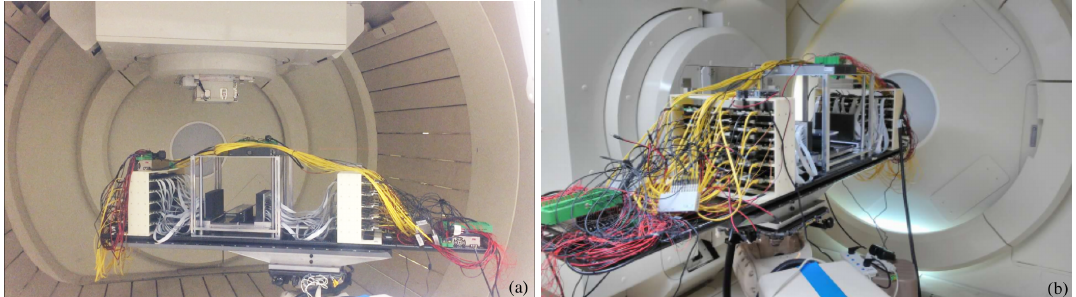
Figure 5. Installation of the prototype of Plug and Imaging sensor PET inside the proton therapy treatment room at the proton therapy center of the Chang Gung Memorial Hospital. The prototype is shown: during the table rotation ( a ); and in the final position, aligned with the proton beam ( b